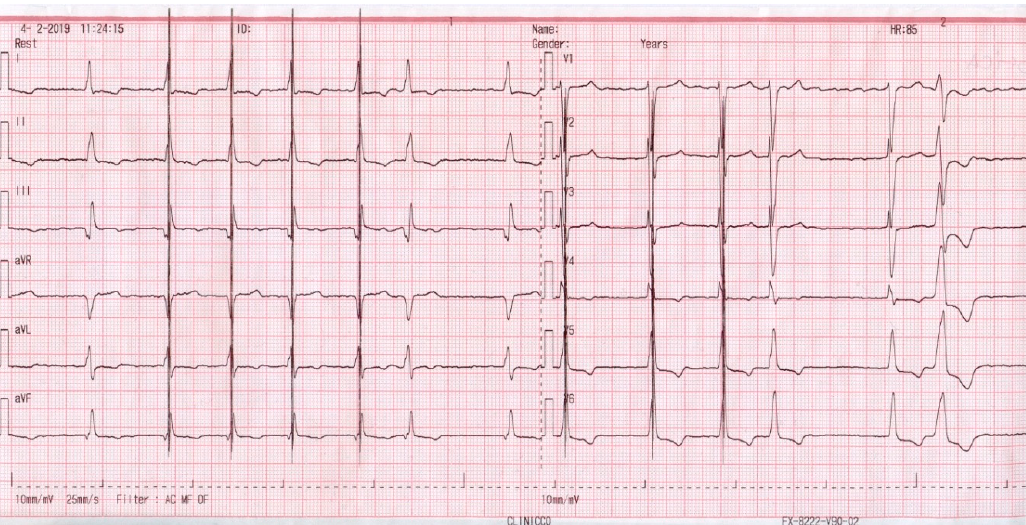
Figure 4. ECG aspect of a patient with atrial fibrillation supported with an ICD and CCM.